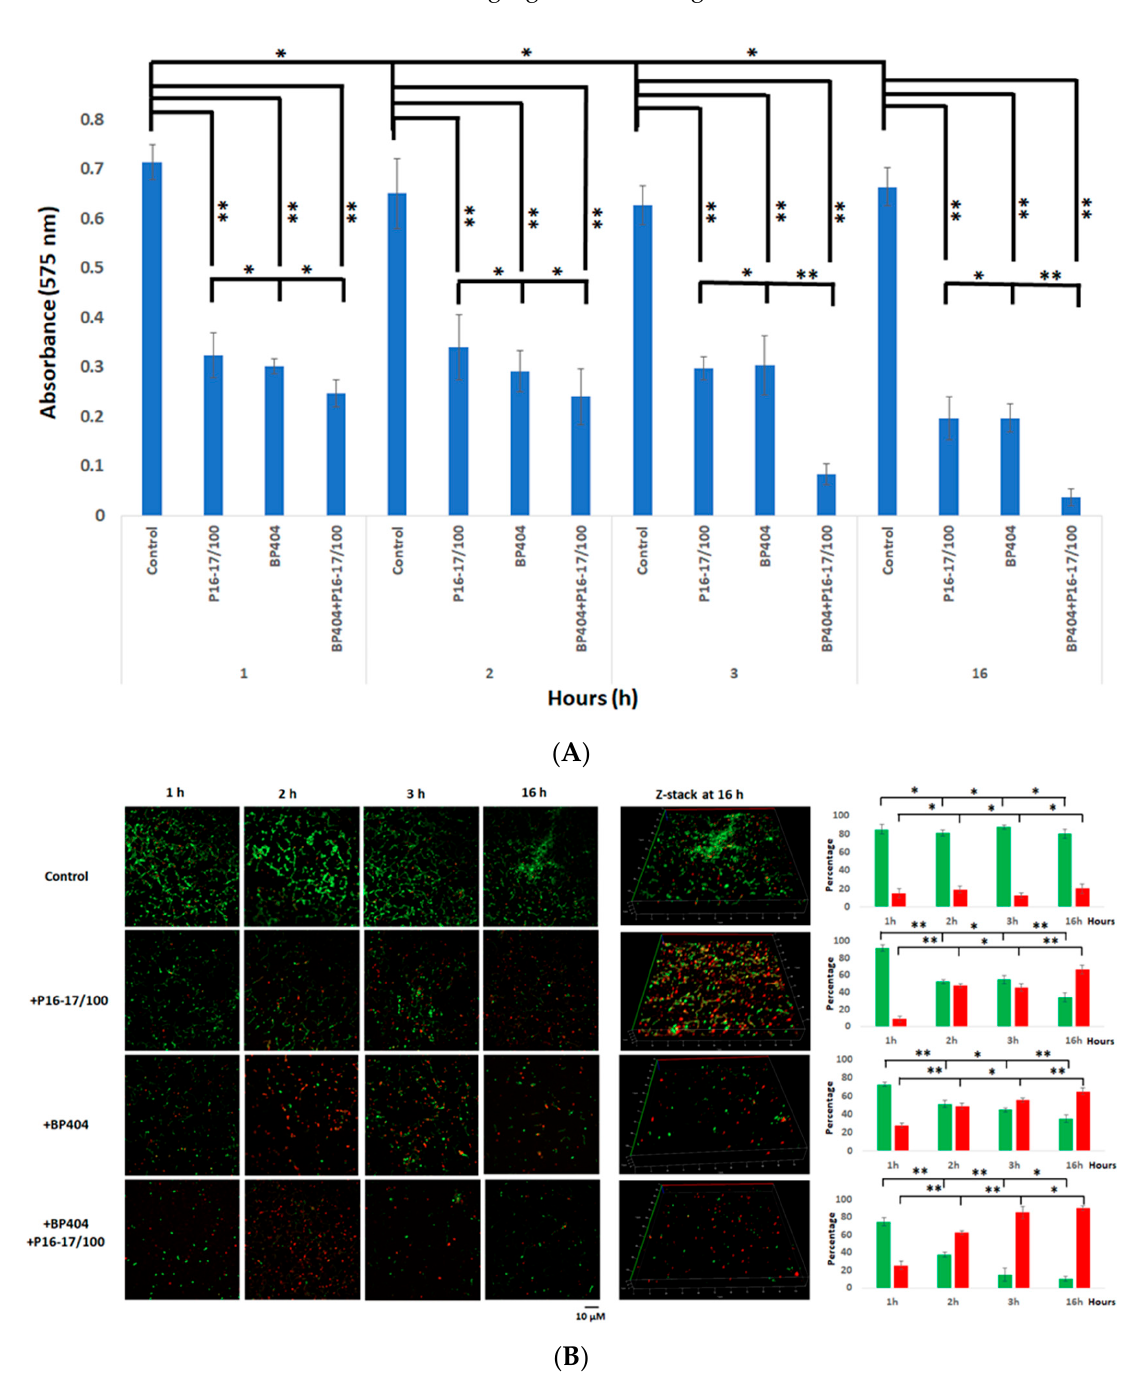
Figure 5. Disruption of bio fi lm and intensity of dead cells in protein/bu ff er-treated samples. ( A ) Crystal violet staining of the control and protein-treated bio fi lm is shown as a graph. The best bio fi lm disruption was observed with the cocktail of BP404 and P16-17/100 against dual bio fi lm at the end of 3 h and 16 h following treatment. ( B ) Microscopy images of pre-formed dual species bio fi lm treated with bu ff er/proteins at speci fi c time points. The 3-dimentional images following treatment at the end of 16 h are shown as z-stack. The indicative percentage of live and dead cells is plo tt ed as